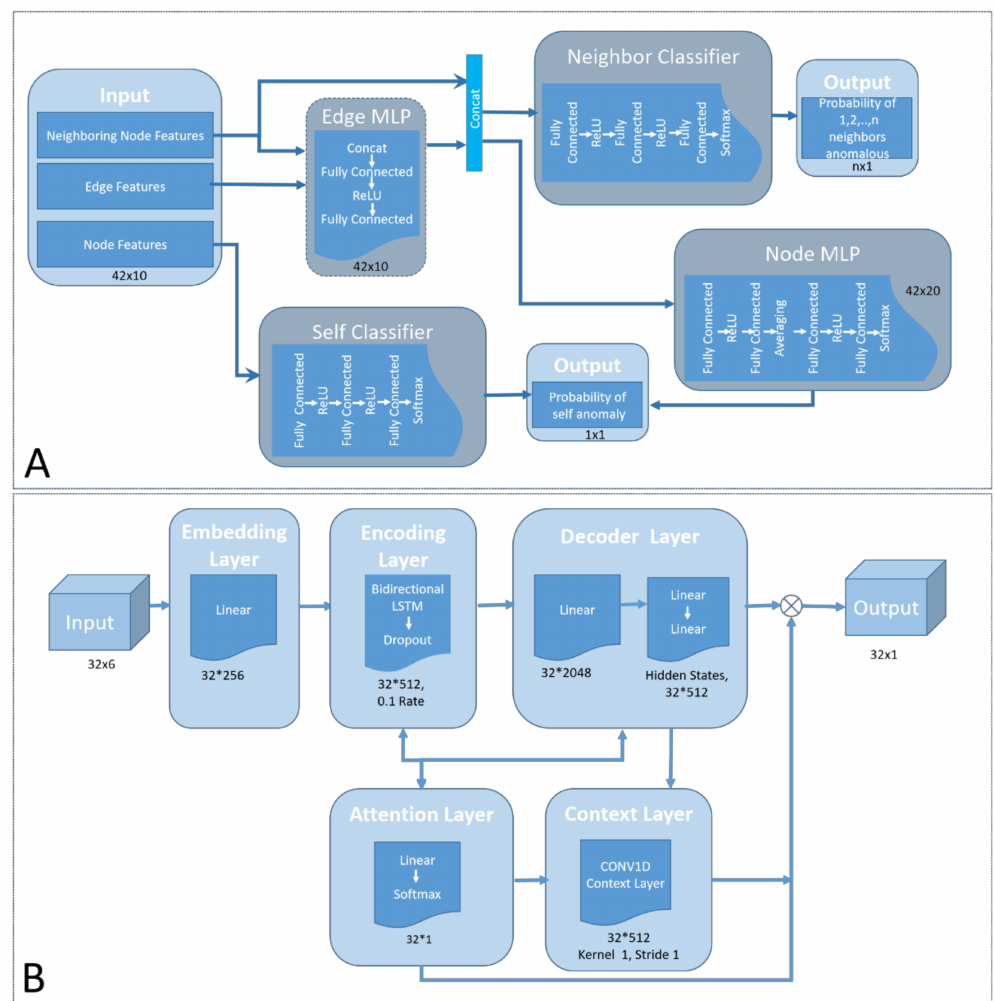
Figure 4. In subfigure ( A ), the graph neural network architecture is shown, comprising two multi- layer perceptrons, both for edge and node deep neural network implementation. Edge deep neural network takes the features of neighbouring nodes as inputs and updates the edge feature vector, whereas the node deep neural network is fed with the adjacent updated edge features, so as to update the feature vector of each particular node. In subfigure ( B ), the pointer network architecture is shown, comprising the encoder m, decoder and attention components that interact to reach a